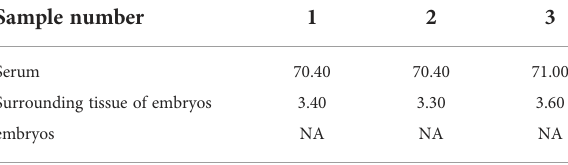
TABLE 6 Isotopic abundance in the different tissues of S. schlegelii before fertilization (unit: 15 N atom%). Sample number 1 Serum Surrounding tissue of oocytes oocytes NA NA NA NA, Natural abundance. TABLE 7 Isotopic abundance in the different tissues of S. schlegelii at the gastrulation stage (unit: 15 N atom%). Sample number 1 2 Serum 70.40 Surrounding tissue of embryos embryos NA NA NA NA, Natural